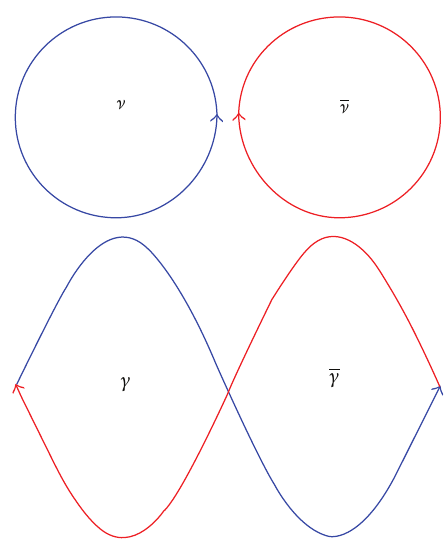
Figure 4: When high-energy protons slow down, pairs of neutrinos ( ] ) with opposite sense of circulation (color coded) will materialize from quanta of actions, that is, from photons that embody the vacuum in pairs of opposite polarization. The resulting leptons are described as single-quantum actions in circular forms. Additionally, the high-energy protons may decelerate by breaking apart the pho- ton pairs to yield two quanta of light ( 𝛾 ) with opposite